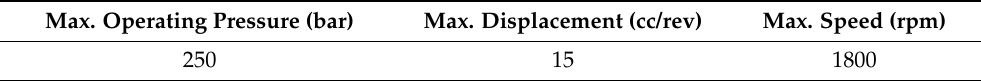
Table 5. Hydraut PQ15 pump main